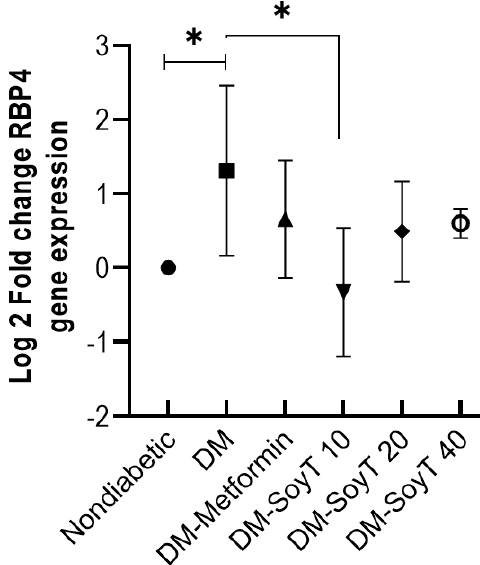
Figure 2. Log 2 fold change in liver PEPCK gene expression. A one-way ANOVA with Dunnett's multiple comparisons post-hoc analysis was used for statistical analysis, with *p<0.05 indicating a significant difference from control